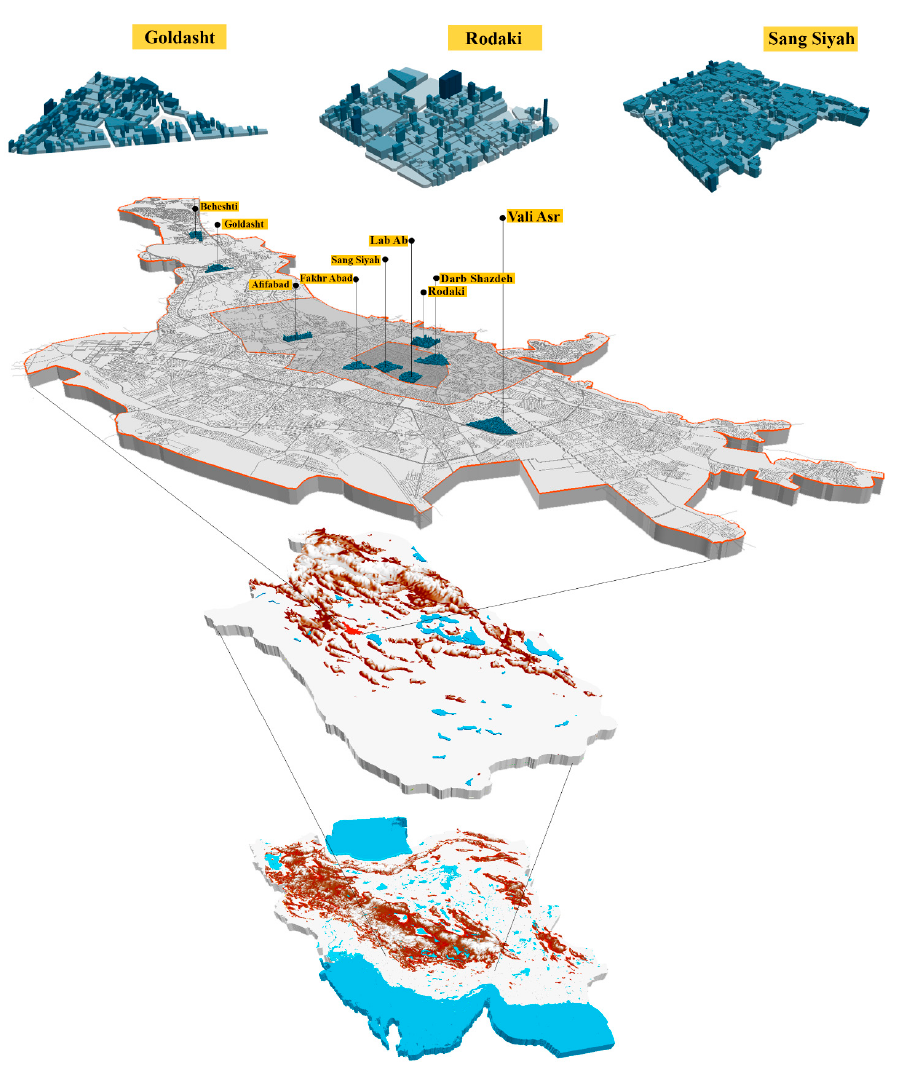
Figure 1. Location of the selected cases.